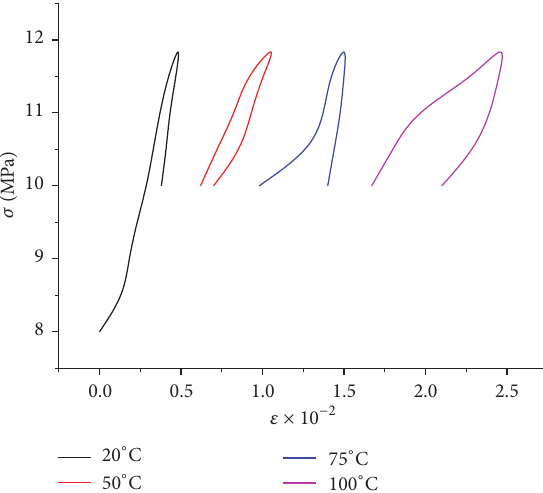
Figure 7: Triaxial stress-strain curves of coal sample 2 # at different temperatures.